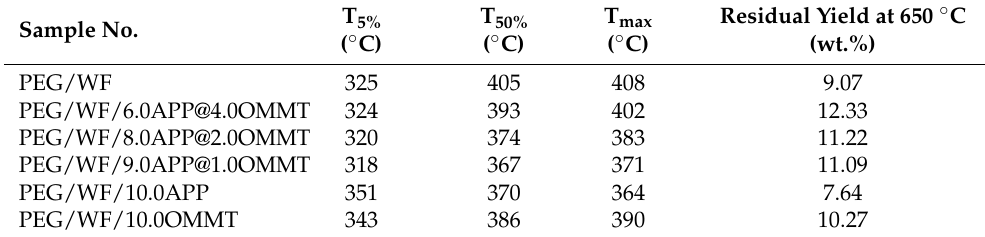
Table 5. TGA data of PEG/WF and its composites.